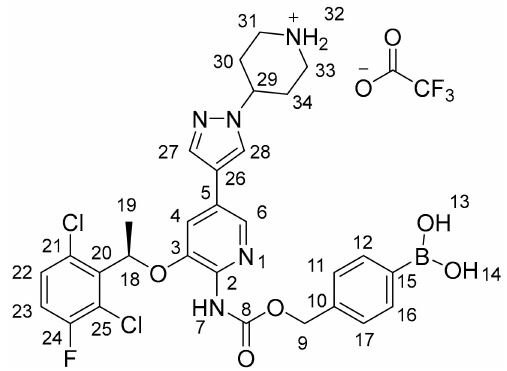
Figure 7. Structure and NMR numbering of prodrug A